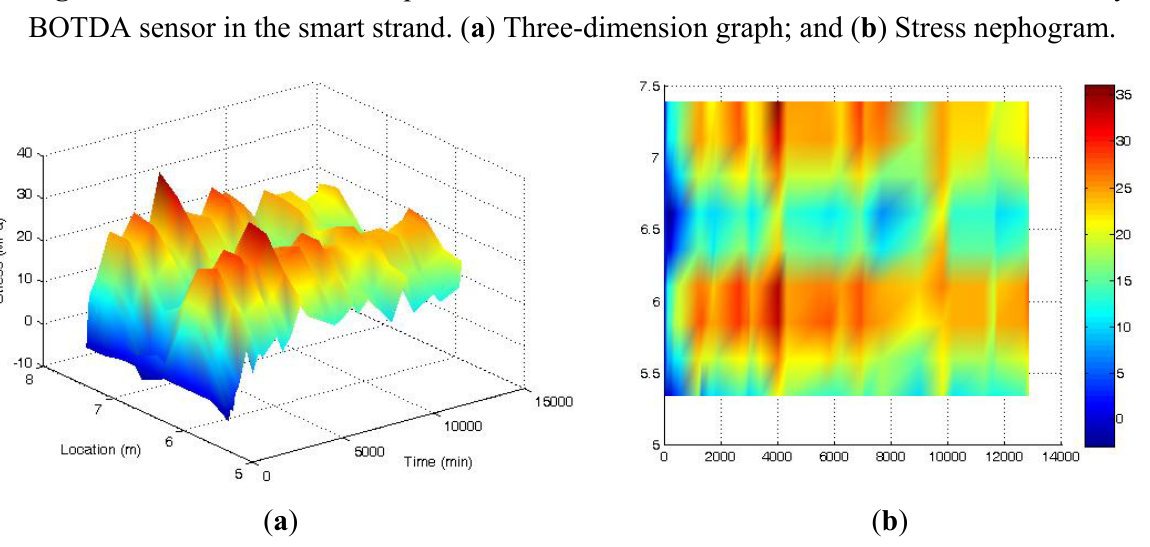
Figure 15. Time-dependent losses of prestressed beam at normal service limit state monitored by BOTDA sensors in two